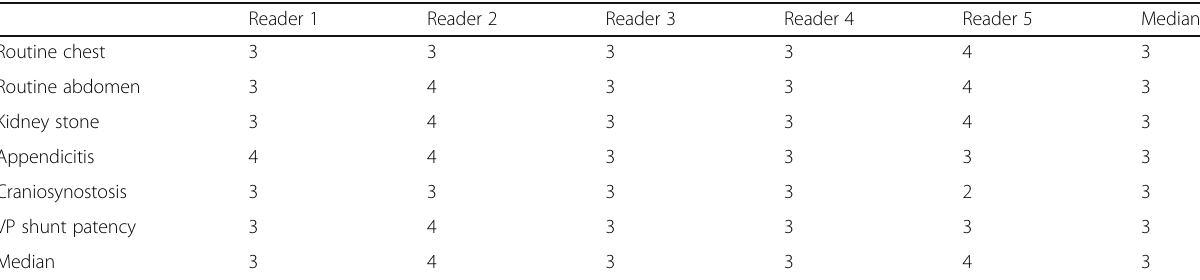
Table 3 Median IQSC for different routine and clinical indication-based CT